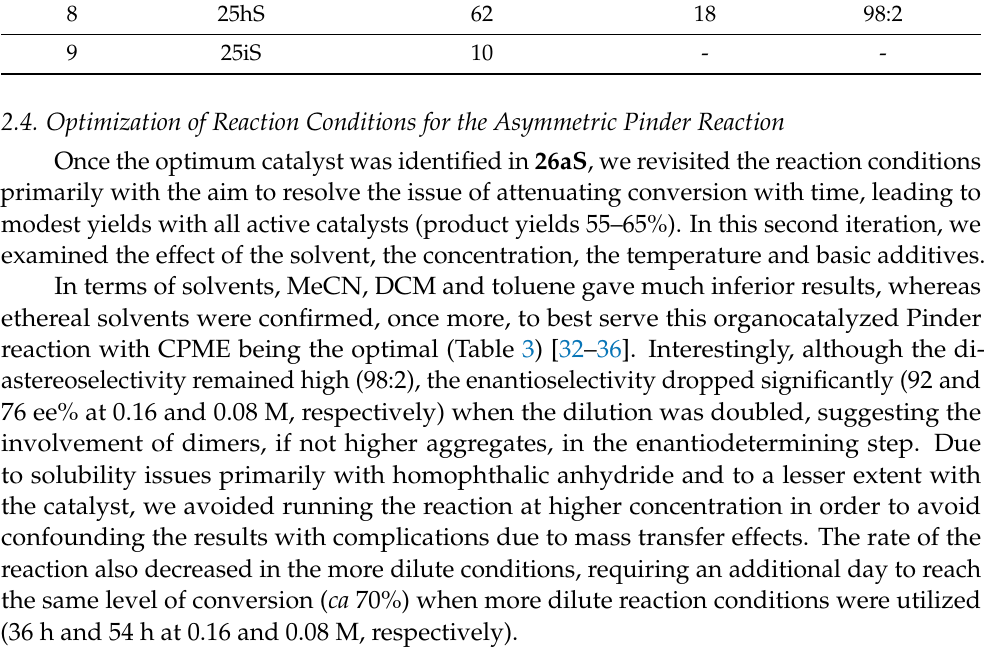
Table 3. Examining the effect of solvents and concentration using 10 mol% of catalyst 26aS at − 10 ◦ C.